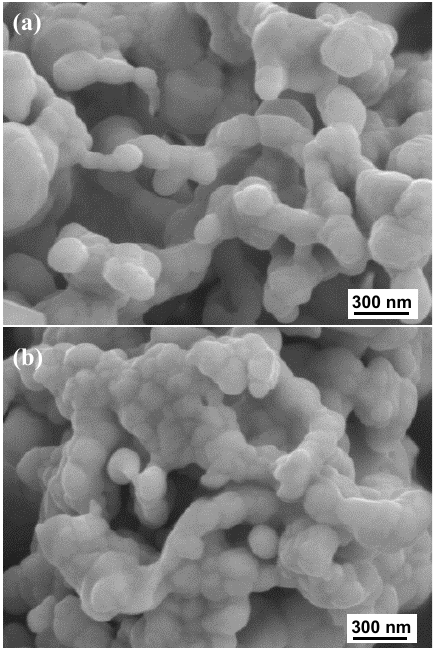
Figure 4. SEM images of the Ag 2 O paste sintered at 150 °C for 3 min in a flowing N 2 gas ( a ) with and ( b ) without the Pt-catalyzed formic acid vapor.